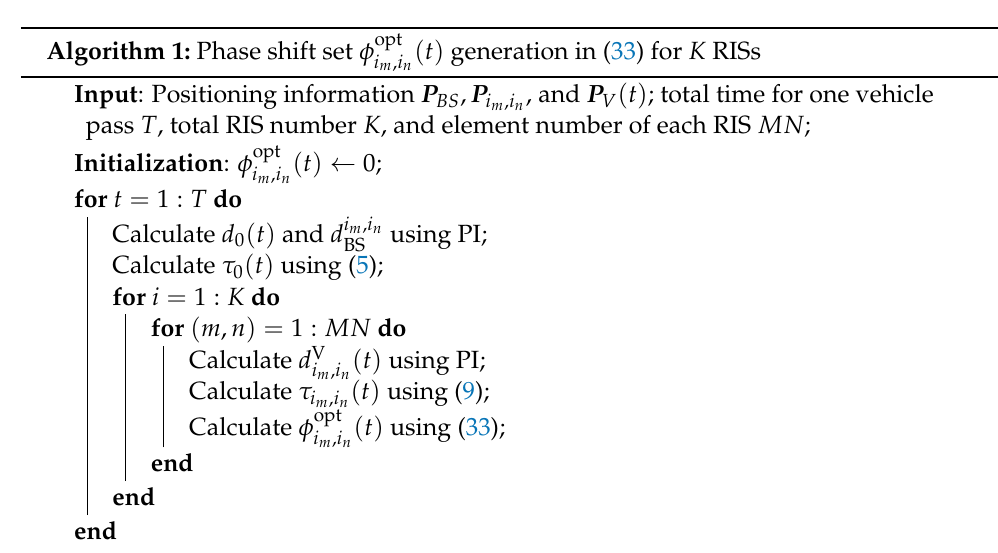
Algorithm 1: Phase shift set φ opt